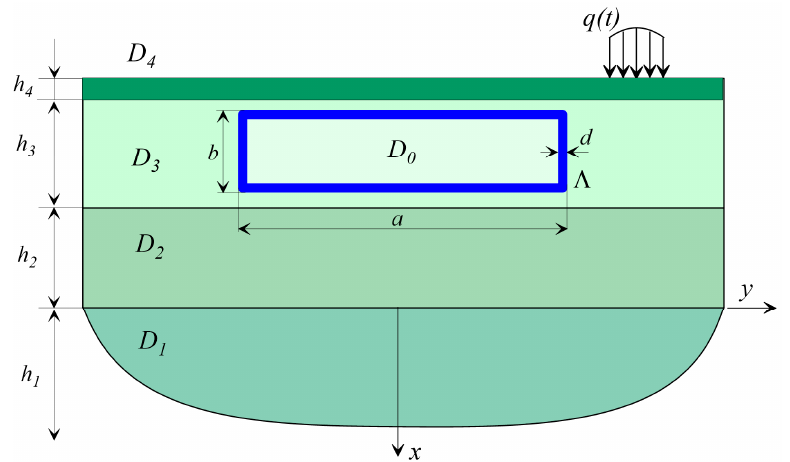
Figure 5. Model for calculating the dynamic response of an object D 0 in a multilayer medium D 1 , D 2 , D 3 and D 4 .